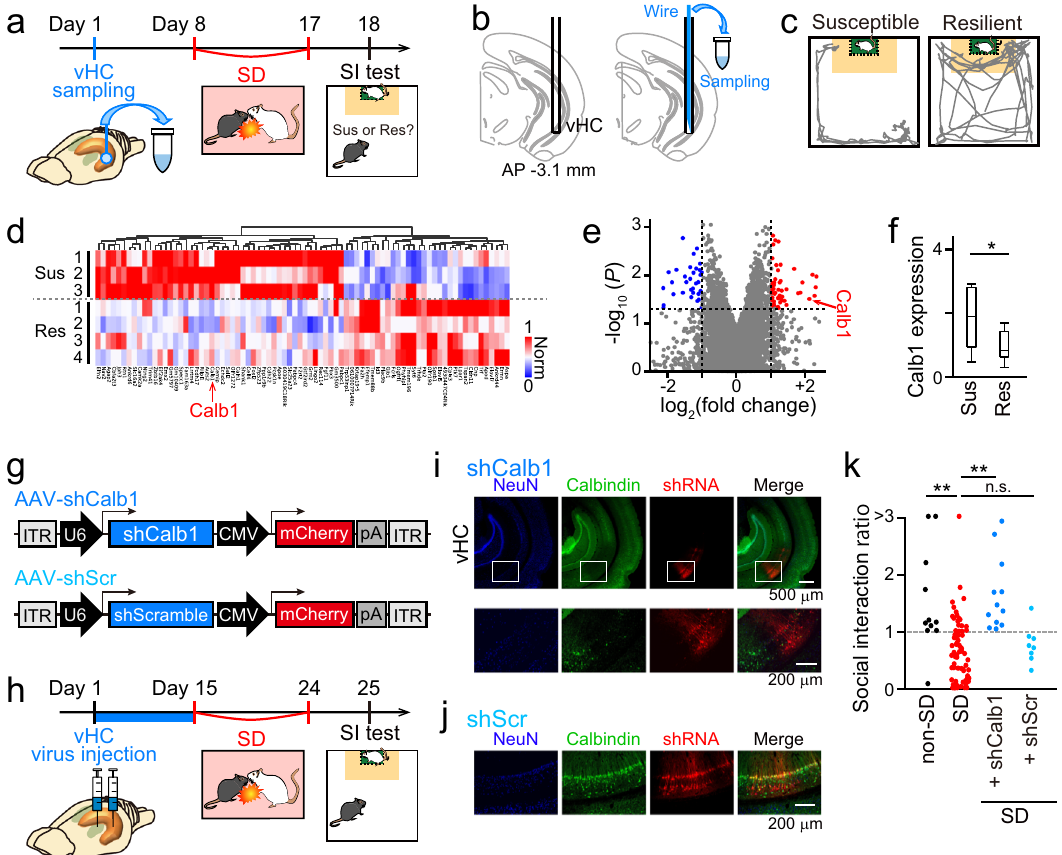
Fig. 1 | Calb1 expression in the vHC regulates stress susceptibility. a Experimentaltimeline of samplecollection, chronicSDexposure, and the SItest. b Schematic illustration of sample collection from the vHC. A guide cannula was implantedintothevHC(left),andametalwire(cyan)wastheninsertedthroughthe cannula to collect a tissue sample (right). c Trajectories of representative suscep- tible(left)and resilient (right)micein the SItest.The orangeregions representthe interaction zone. d Heatmap showing hierarchical clustering of gene expression patterns collected from the vHC before SD stress. After SD stress exposure, three stress susceptible and four stress resilient mice were identi fi ed in subsequent SI testsandtheirgeneexpressionpatternswerecompared.The80genesthatshowed amorethan2-folddifferenceinexpressionwitha P value<0.05(correspondingto e ) between the two groups are shown. e Volcano plot showing the fold change in the expression of and P value of individual genes in stress susceptible mice com- pared with stress resilient mice. The vertical dotted lines represent a 2-fold dif- ference, and the horizontal dotted line represents the signi fi cance cutoff (one- sided Student ’ s t -test, P = 0.05). The red and blue dots indicate signi fi cantly